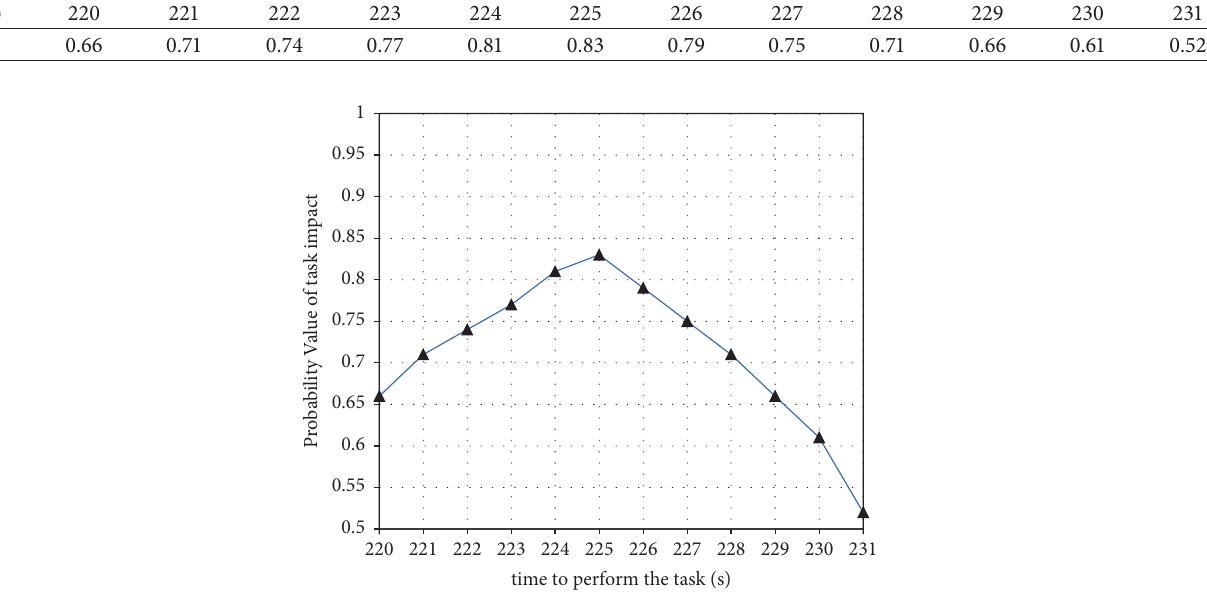
Figure 8: Threat level curve of the obstacle to the UUV task. Table 7: Threat probability of the insufficient energy margin event to UUV task.